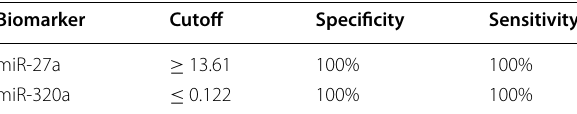
1.000, cutoff 13.61) and miR‑320a ( AUC = ≥